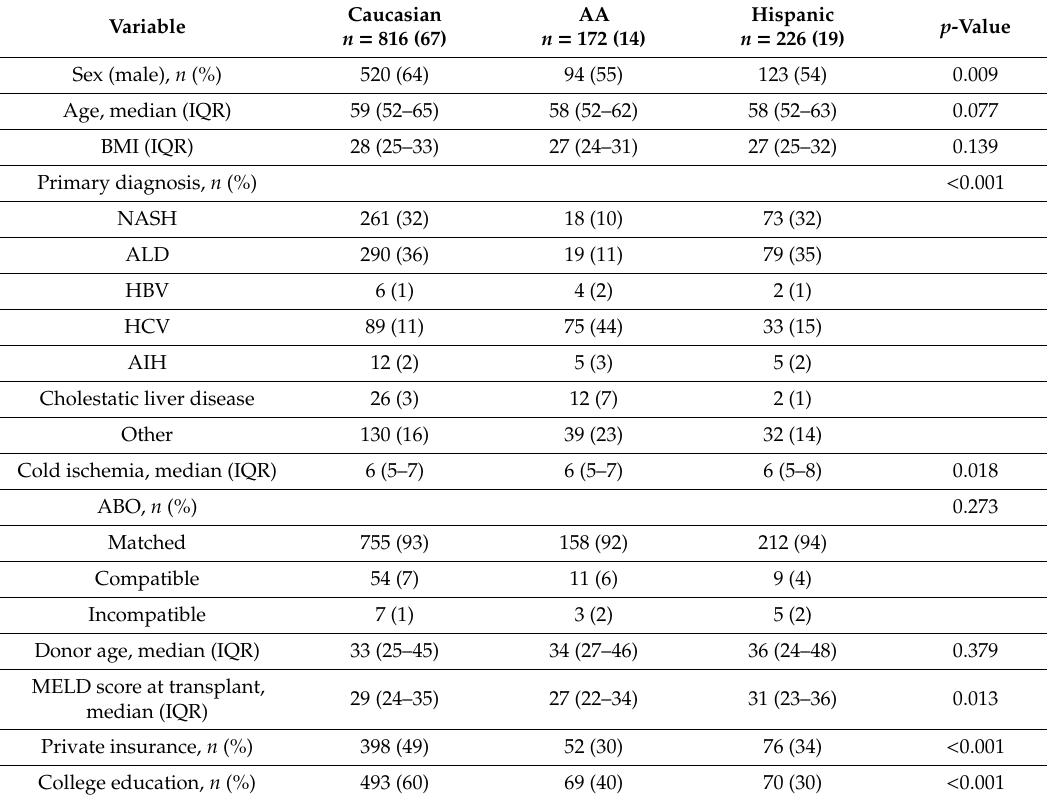
Table 1. Baseline demographic and clinical characteristics of patients who underwent SLKT grouped according to ethnicity ( n =